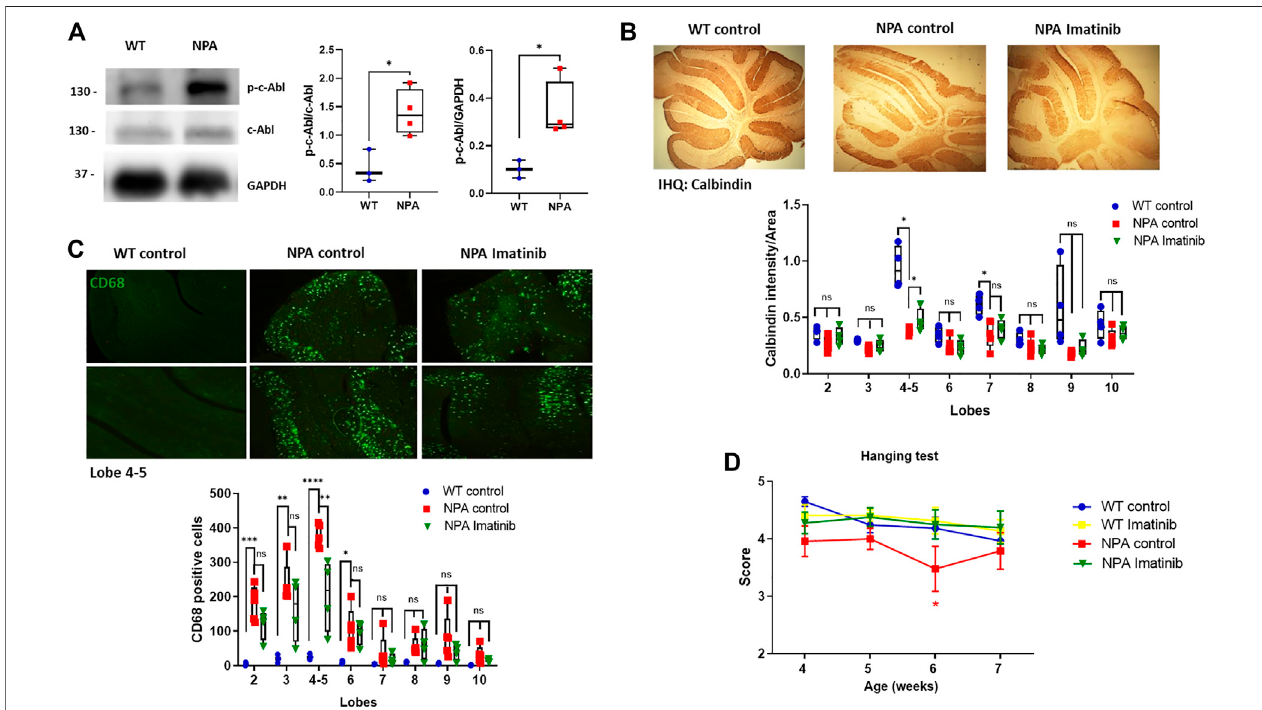
FIGURE 3 | Acute imatinib treatment decreases neuronal death in the cerebellum and improves locomotor function in NPA mice. (A) WT and NPA brain homogenates (50 μ g protein/lane) from mice at 4 weeks old were analyzed by Western blot. The graph shows quanti fi cations of p-c-Abl levels normalized by GAPDH and c-Abllevels.The number ofanimals was:WT = 3; NPA = 4; Student ’ s t -test: * p < 0.05. (B) WT and NPA mice were i.p. injected with imatinib (12.5 mg/kg) or vehicle from 3 weeks of age until 7 weeks of age. The Purkinje neuron marker calbindin was analyzed by immunohistochemistry. A quanti fi cation of calbindin- immunoreactive Purkinje cell bodies in cerebellar sections is shown. (C) CD68 marker was evaluated by immuno fl uorescence analysis in the cerebellum from WT and NPAmice.For (B,C) ,thenumberofanimalswasWTcontrol=3;NPAcontrol=5;NPAimatinib=4.Imagesweretakenwith×4objective.ANOVA,Tukey post-hoc: * p < 0.05; ** p < 0.01; *** p < 0.001; **** p < 0.0001 (D) Mice were treated for 4 weeks and motor coordination was assessed weekly by the hanging test. Data are shown as mean±SEM.ANOVA,Tukey post-hoc :* p < 0.05,NPAcontrolisstatisticallydifferentfromWTcontrolandNPAwithimatinib.Thefollowingnumberofanimalswasused: WTcontrol=11;WTimatinib=10;NPAcontrol=8;NPAimatinib=9.Inthebox-and-whiskerplots,thecenterlinedenotesthemedianvalue,edgesareupperandlower quartiles, whiskers show minimum and maximum values and points are individual